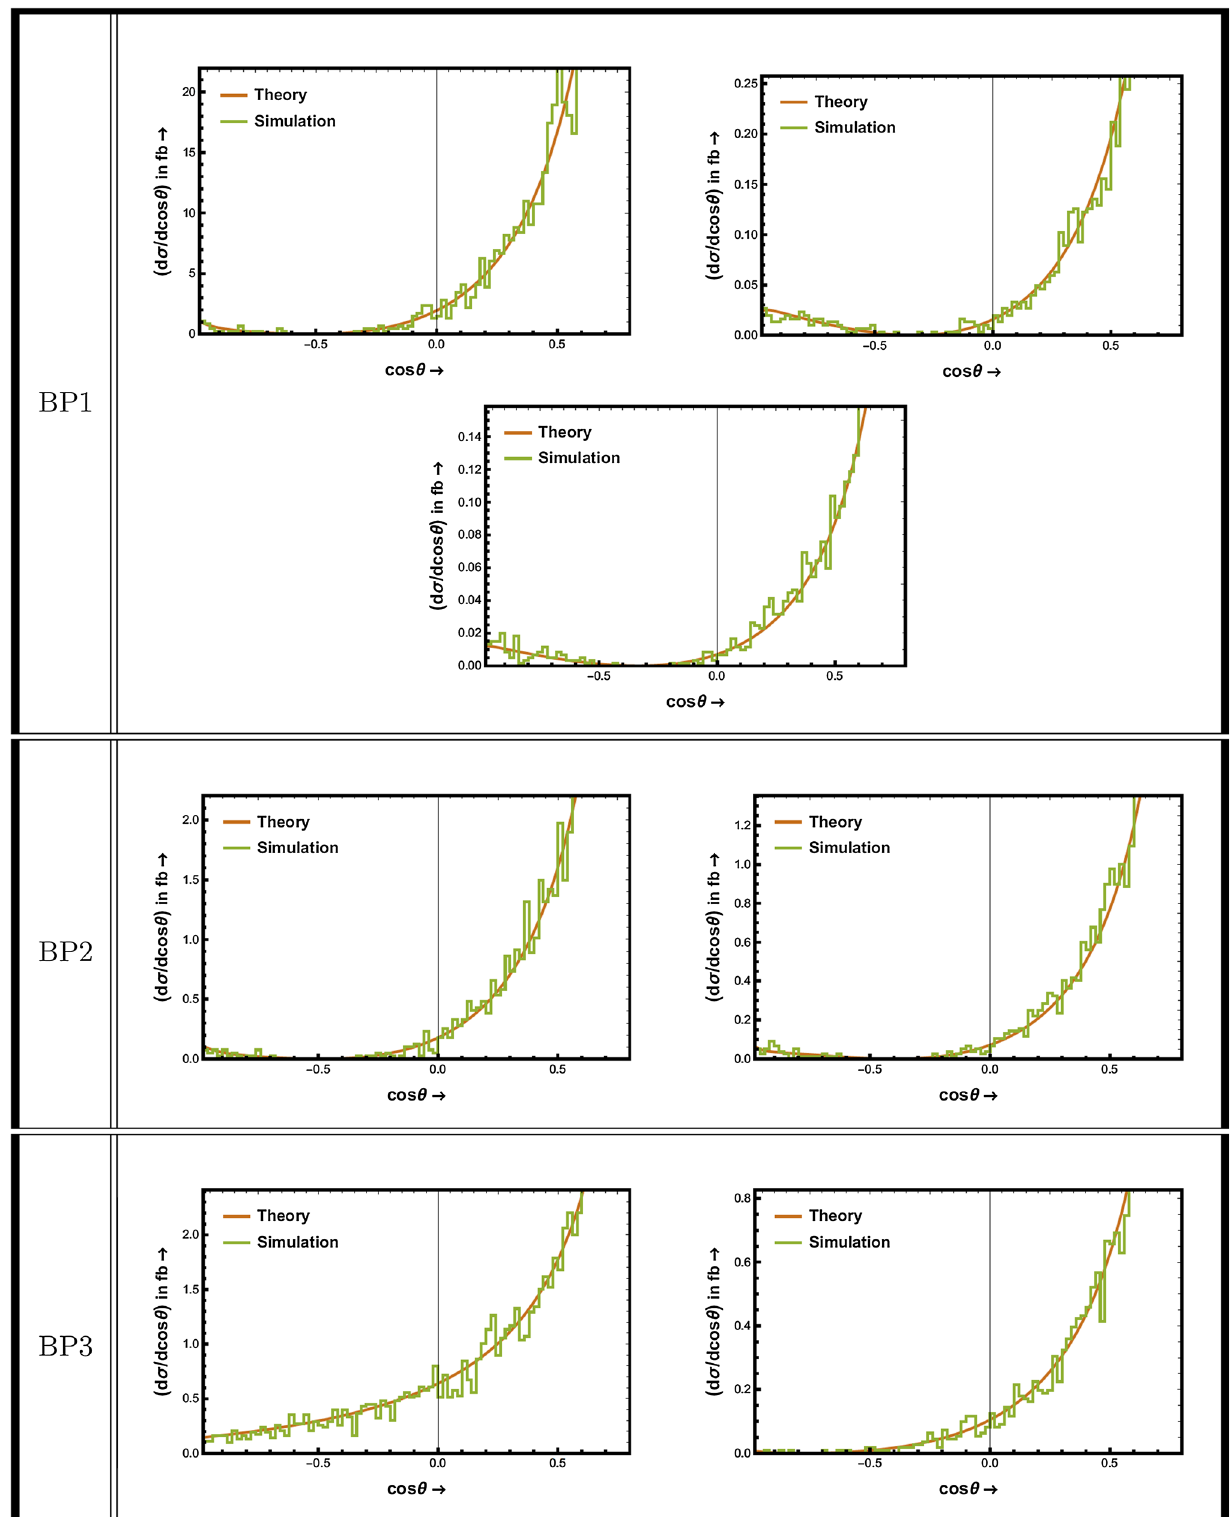
Fig. 6 Angular distribution for the production of ( S + 1 / 3 ) c at various center of momentum energies for different benchmark points, arranged in the order of Table 6. The brown (smooth) curves indicate the theoret-